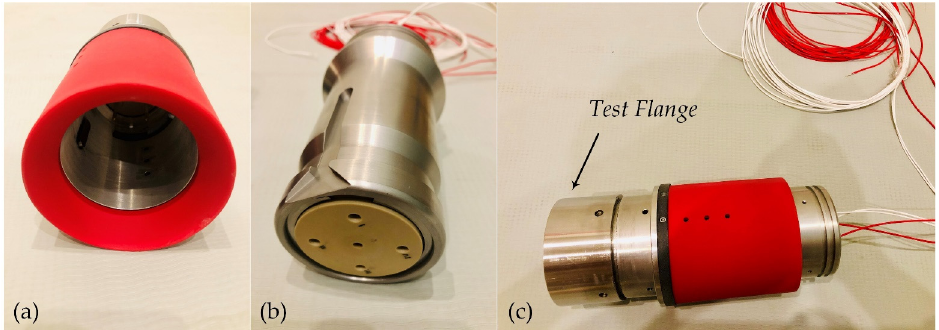
Figure 16. A prototype of the proposed wet-mateable electrical connectors: ( a ) the plug unit, ( b ) the receptacle unit, and ( c ) the fully-mated state of the prototype.